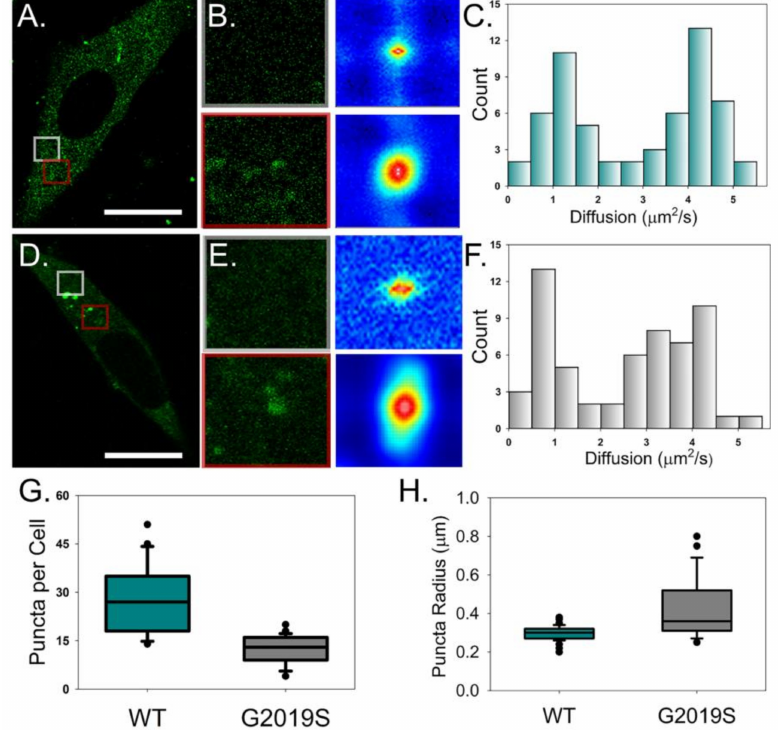
Figure 2. Fluctuation analysis reveals multiple populations of diffusing LRRK2-GFP. ( A , D ) A representative average intensity image of WT LRRK2-GFP ( A ) and G2019S-GFP ( D ) collected using 2P confocal microscopy and fluctuation analysis conditions. Scale bar is 15 µ m. ( B , E ) Intensity images (left column) and autocorrelation functions (ACF) (right column) corresponding to the colored boxed ROIs (grey: top, red: bottom) from the full cell image. ( C , F ) Average histogram of diffusion rates obtained for WT LRRK2-GFP ( C ) and G2019S-GFP ( F ). Box plots of WT LRRK2-GFP (dark cyan) and G2019S LRRK2-GFP (gray) comparing the number of puncta per cell ( G ) and cytosolic puncta radius ( H ). Statistical analyses were performed using a two-sample t -test ( p < 0.05). n ≥ 20 cells per